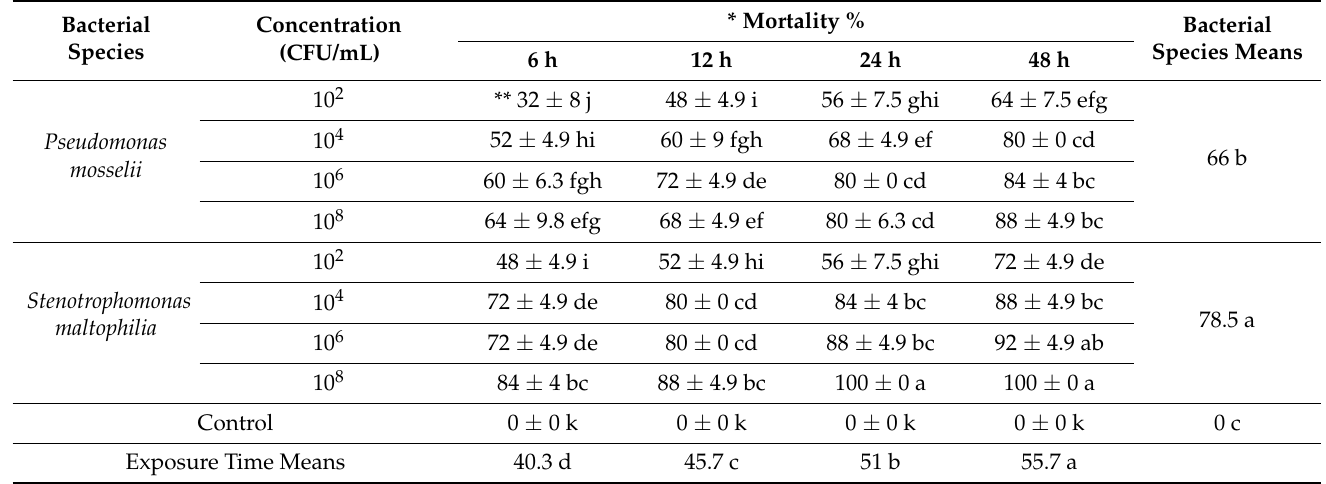
Table 5. Larvicidal activity of two bacterial species cells on the pomegranate butterfly, Virachola livia , under laboratory